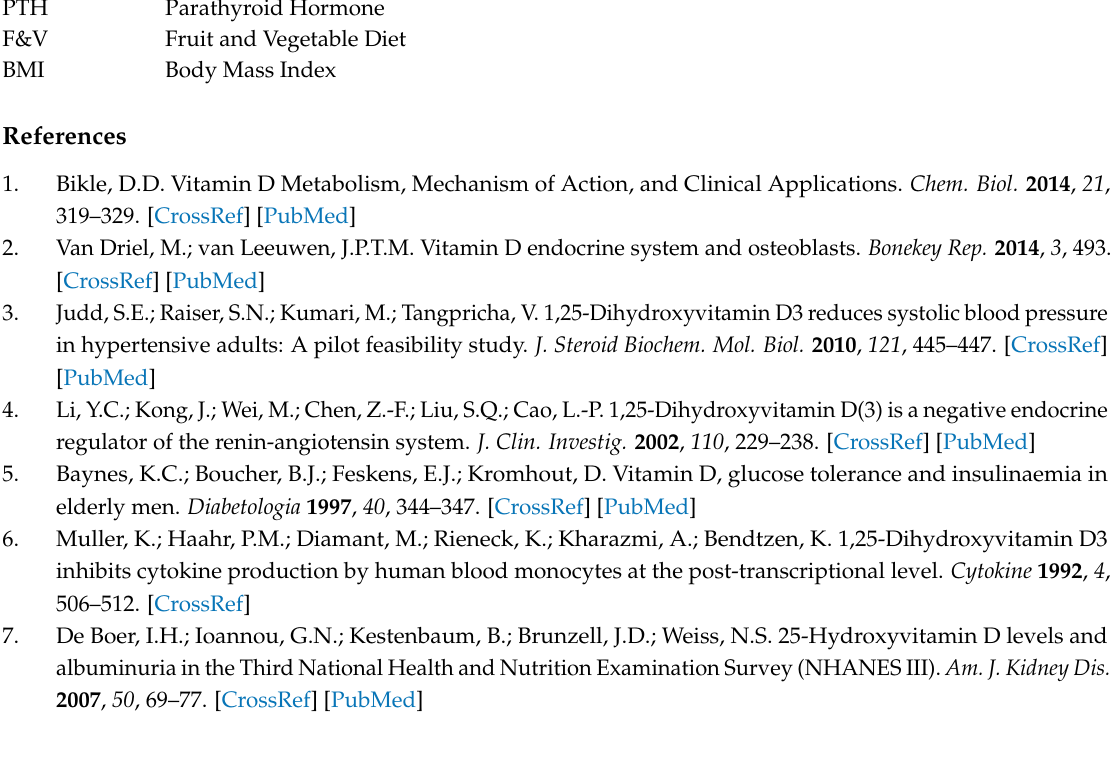
Figure S1: CONSORT flowchart, Figure S2: CONSORT 2010 Checklist of Randomized Trial ,Table S1:Nutrient Targets, Menu Analyses, And Average Daily Servings Of Foods, According To Diet, Table S2: Missing Data By Clinical Center, and Table S3: Comparisons Of Mean Changes In Calcitriol, Parathyroid Hormone, And Urinary Excretion Of Calcium Between Diets By Race And